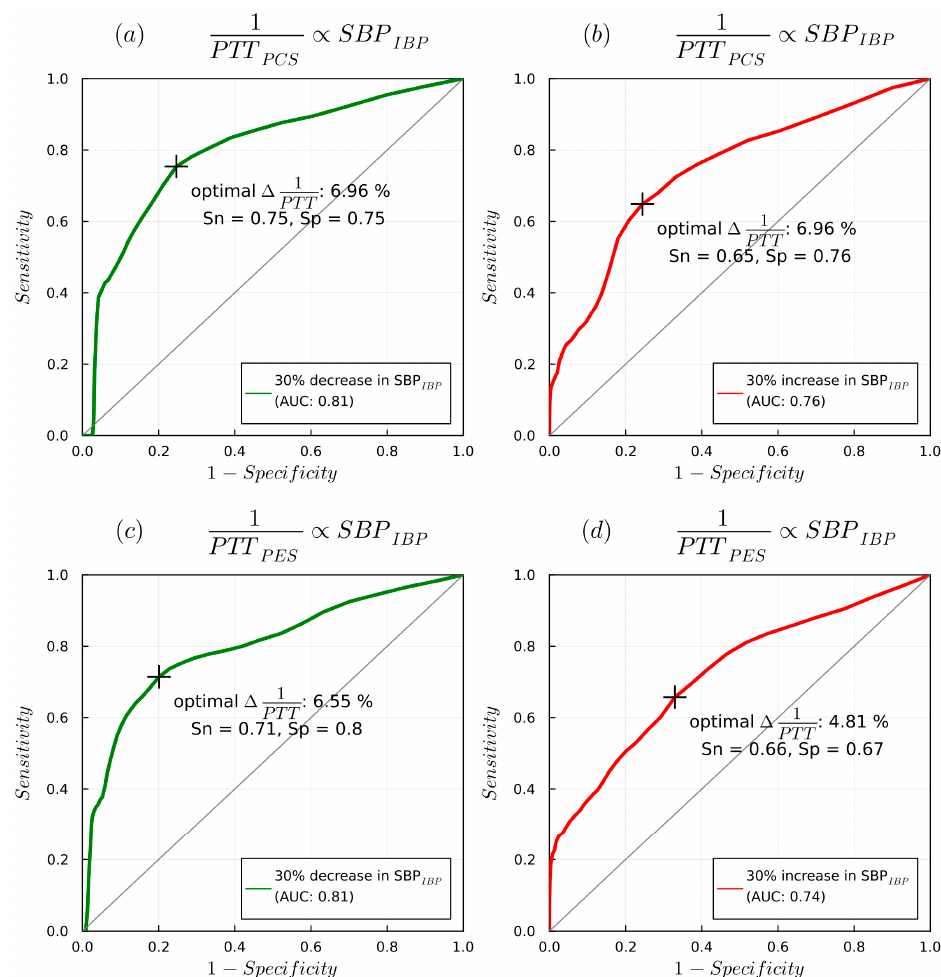
Figure 11. AUROC curves detailing 1/PTT changes detected with PES/PCS sensors with changes in SBP IBP : ( a ) delta of 1/PTT PCS with decrease in SBP IBP , ( b ) delta of 1/PTT PCS with increase in SBP IBP , ( c ) delta of 1/PTT PES with decrease in SBP IBP , ( d ) delta of 1/PTT PCS with increase in SBP IBP .